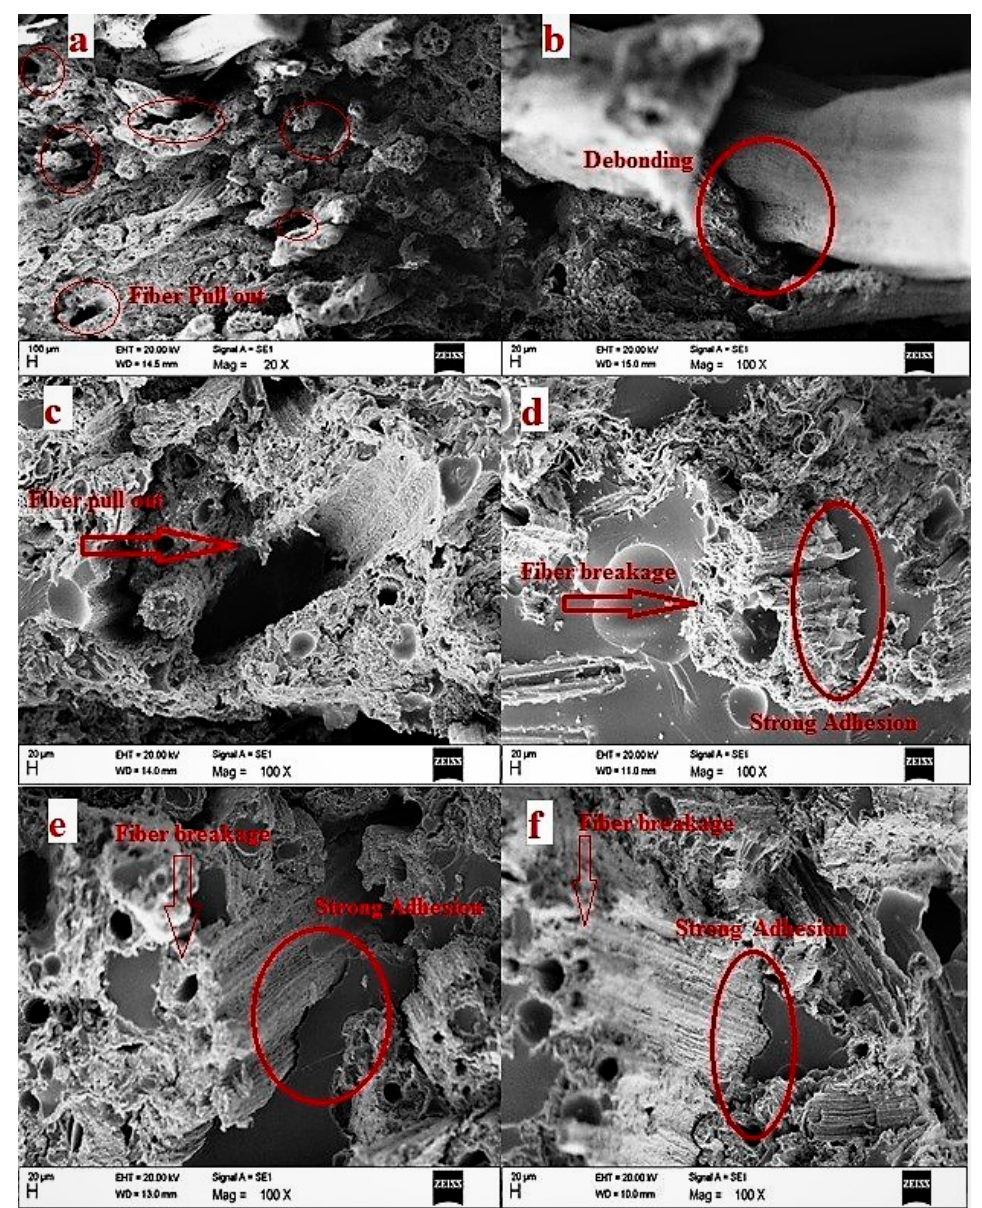
Figure 6. ( a – c ) shows the SEM images of untreated Typha fibers, ( d – f ) shows fractured surfaces of the alkali treated Typha fiber reinforced epoxy composites with a duration of 2, 4 and 8 h